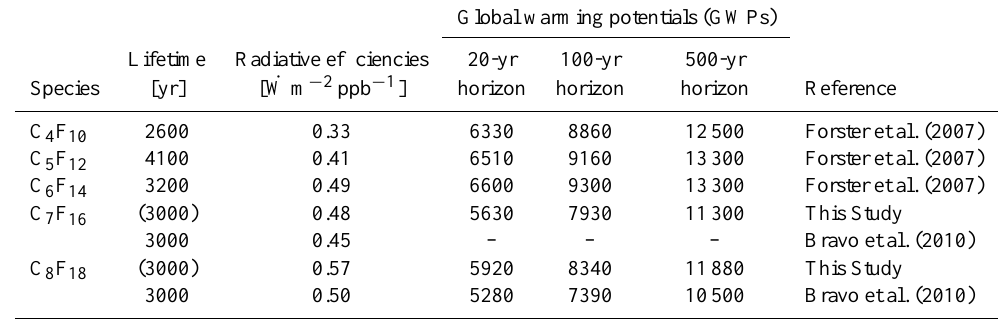
Table 1. Lifetimes, radiative efficiencies and global warming potentials (by mass) of C 4 F 10 , C 5 F 12 , C 6 F 14 , C 7 F 16 and C 8 F 18 .